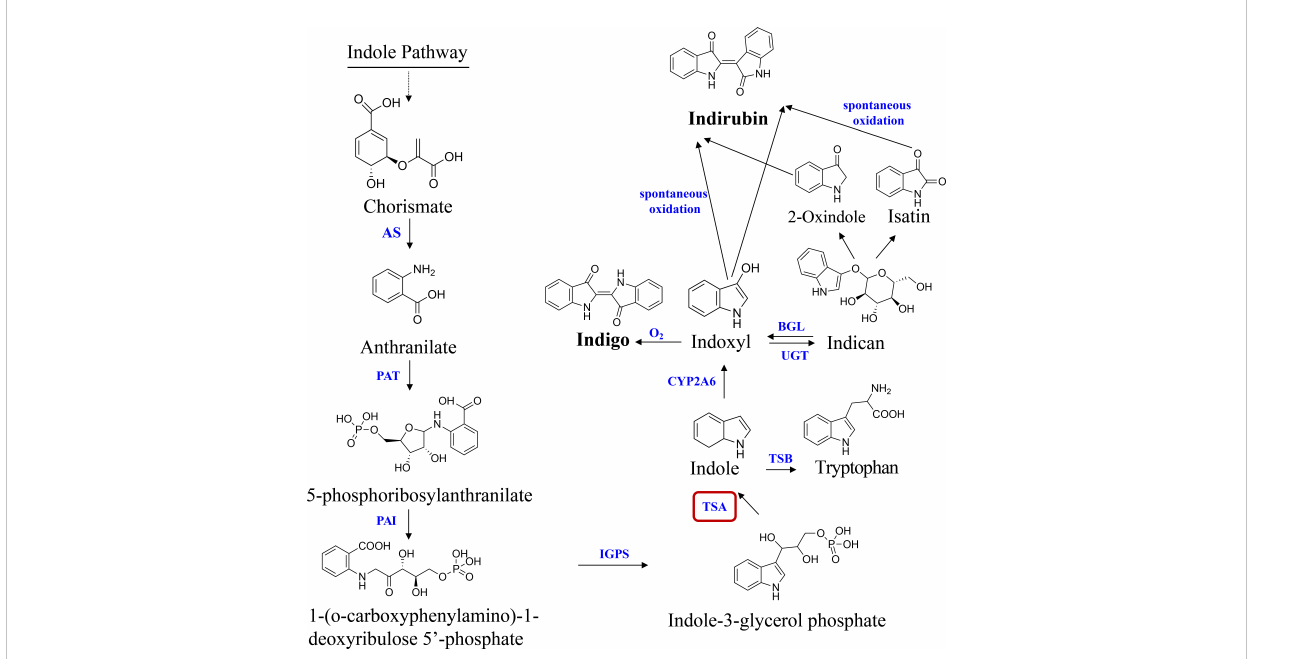
FIGURE 1 Pathway of indole alkaloids biosynthesis in B cusia . AS, anthranilate synthase; PAT, phosphoribosyl anthranilate transferase; PAI, phosphoribosyl anthranilate isomerase; IGPS, indole-3-glycerol phosphate synthase; TSA, tryptophan synthase alpha-subunit; TSB, tryptophan synthase beta- subunit; CYP2A6, cytochrome P450 monooxygenase; BGL, b -glucosidase; UGT, UDP-glucosyltransferase. Solid lines indicate a single step; dotted lines indicate multiple